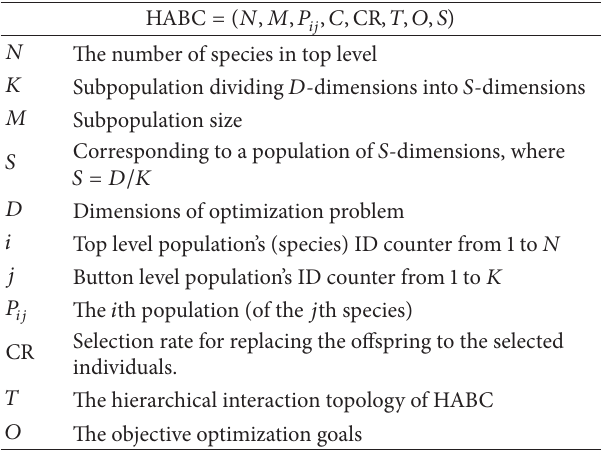
Table 1: Parameters of the